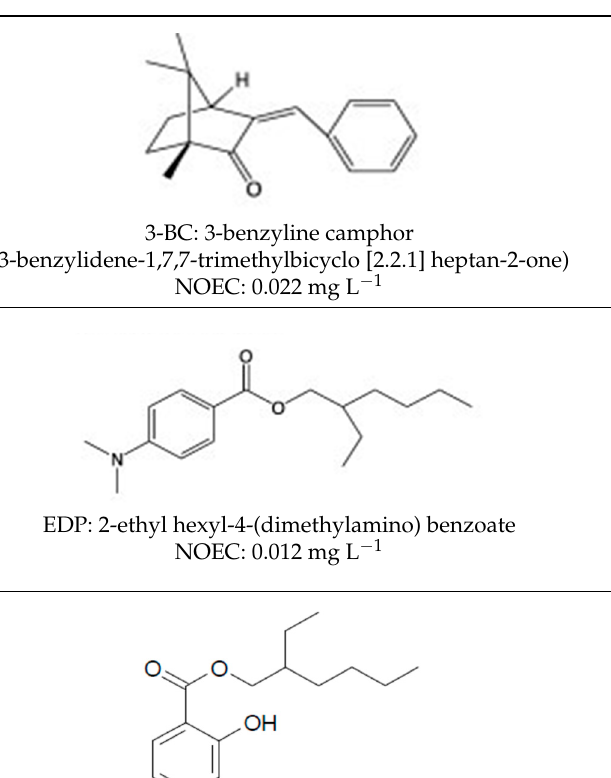
Table 1. Chemical Structures, IUPAC names and NOEC concentration of selected UVFs.